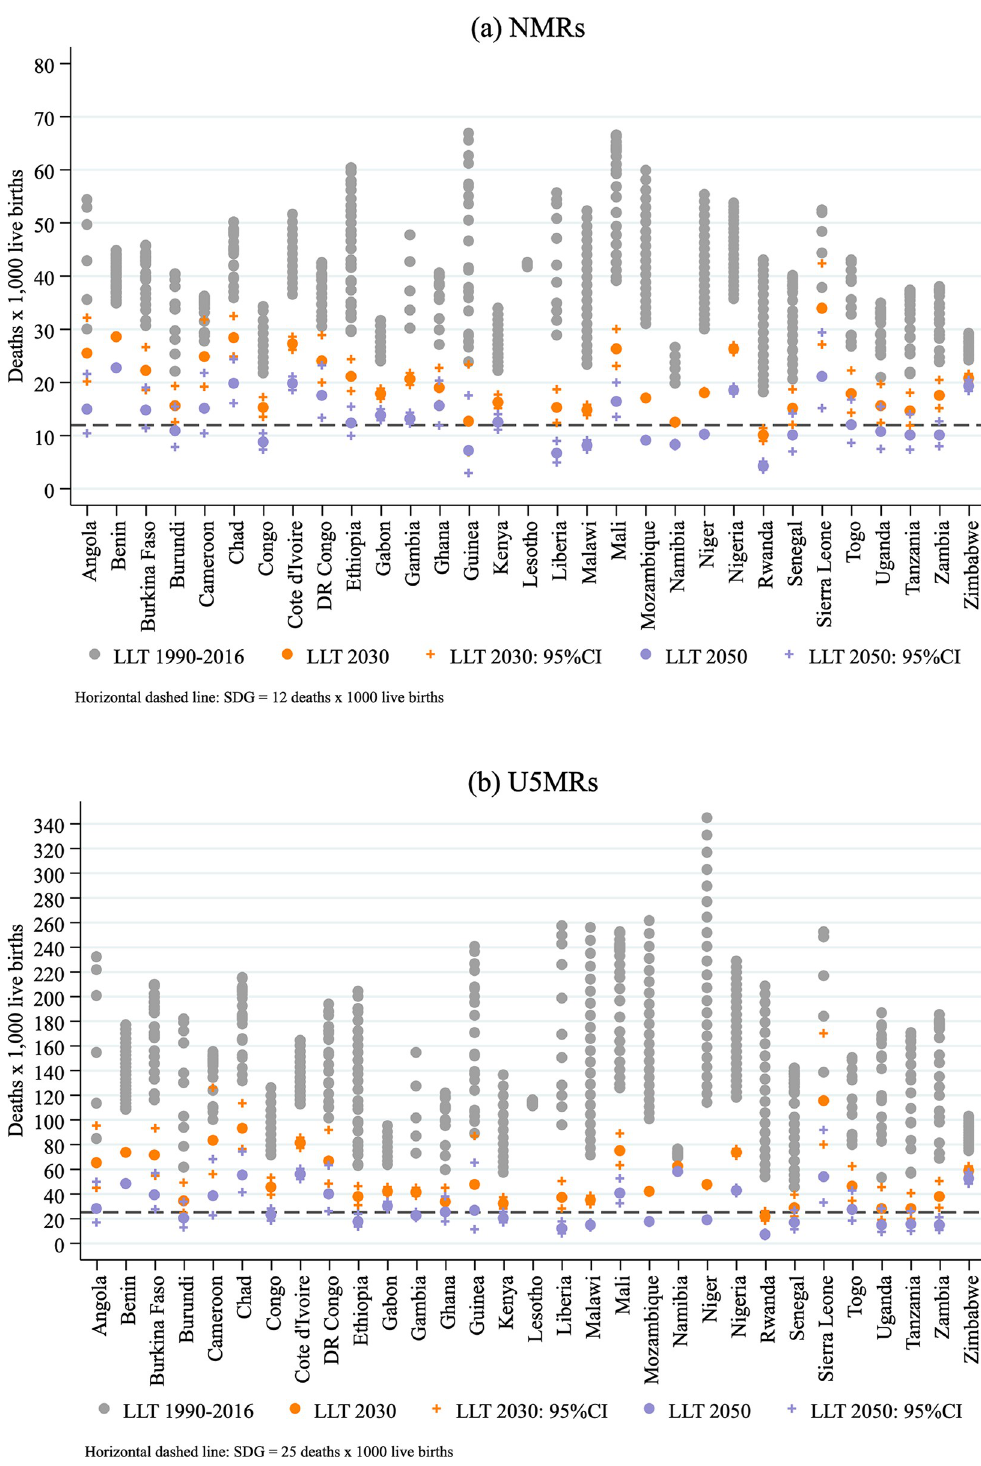
Fig 3. Forecasts of NMRs and U5MRs by 2030 and 2050 based on the LLT model and assessment of SDG-3 targets in 31 SSA countries. (a) NMRs and (b) U5MRs. Predictions for Lesotho were precluded by the poor quality of data and great uncertainty in the estimates and uncertainties. We report unbiased error bounds for our prediction models for 2030 and 2050. LLT, Li–Lee–Tuljapurkar; NMR, neonatal mortality rate; SDG-3, Sustainability Development Goal 3; SSA, sub- Saharan Africa; U5MR, under-5 mortality rate.